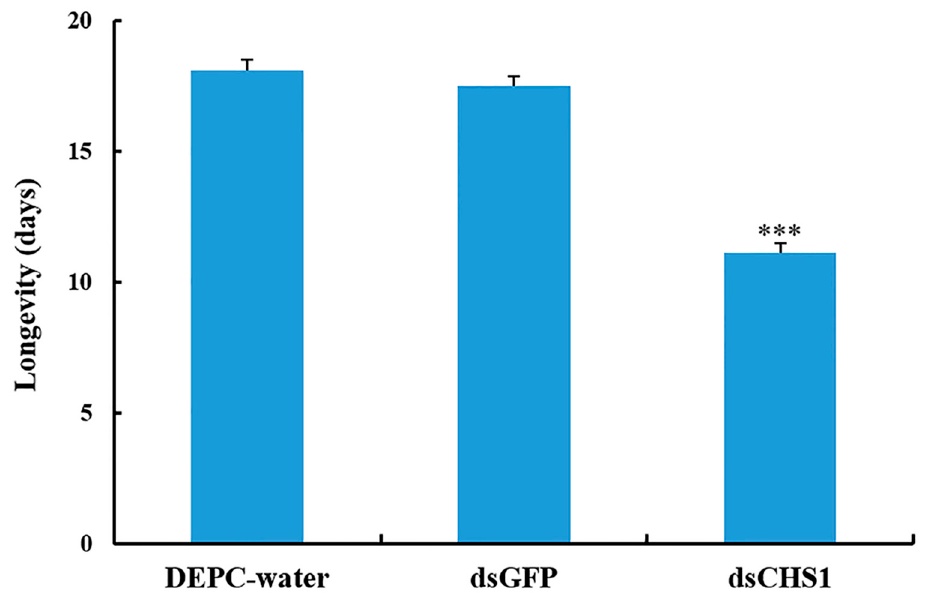
Figure 4. Impact of CHS1 gene silencing on adult longevity of A. gossypii , previously fed artificial diets containing DEPC-water, dsGFP, and ds CHS1 at their nymphal stage (third instar). The values are presented as the mean ( ± SE). Thirty individuals per experimental group (DEPC-water, dsGFP, and dsCHS1) were used, and each aphid was considered as a single replicate. Treatments were compared using one-way ANOVA (Tukey’s HSD test, p < 0.05). *** represents p < 0.001.